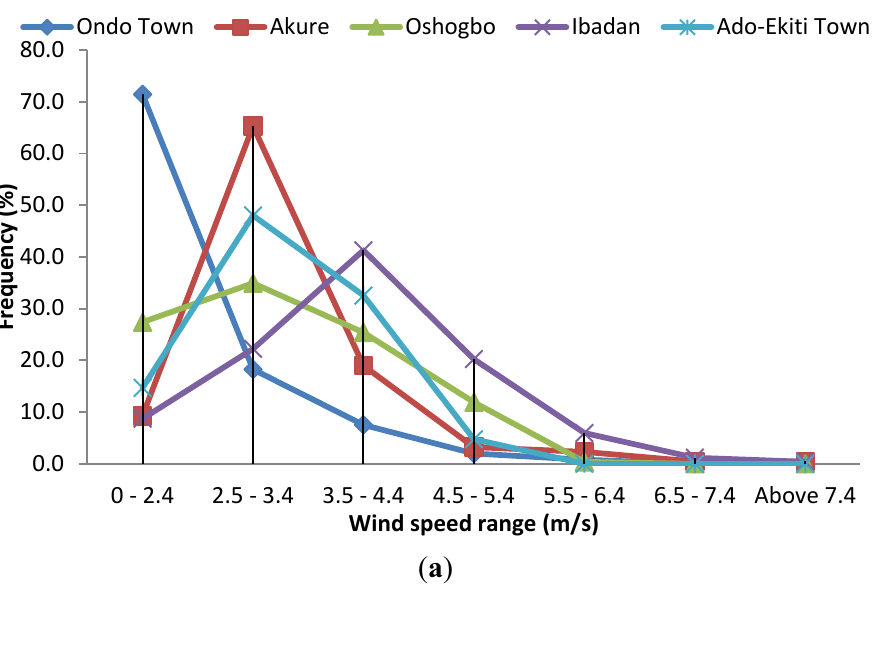
Figure 5. Wind speed Frequency of occurrence for ( a ) stations in Ondo, Osun, Oyo and Ekiti States; ( b ) stations in Lagos and Ogun States.